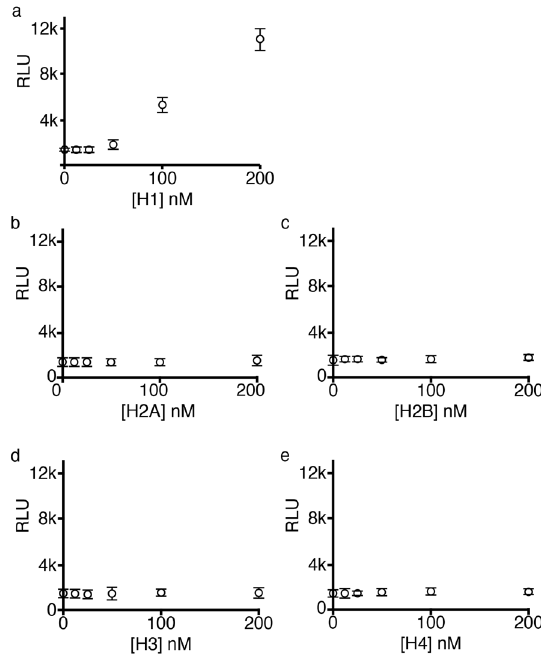
Figure 3. Linker histone H1 is neurotoxic. Dissociated cortical neurons were cultured for 48 hrs and histones were applied for a further 24 hrs. Cell death was determined by luminescence to measure protease release and was expressed as relative luminescence units (RLU). For clarity RLU means are expressed as +/- 2 x standard deviation (SD). Histone H1 caused dose-dependent death of cortical neurons ( a ) while core histones H2A, H2B, H3 and H4 were without effect up to 200 nM ( b – e ). Cell death as measured by luminescence was confirmed directly via phase contrast microscopy of dissociated cortical neurons in culture (Figure